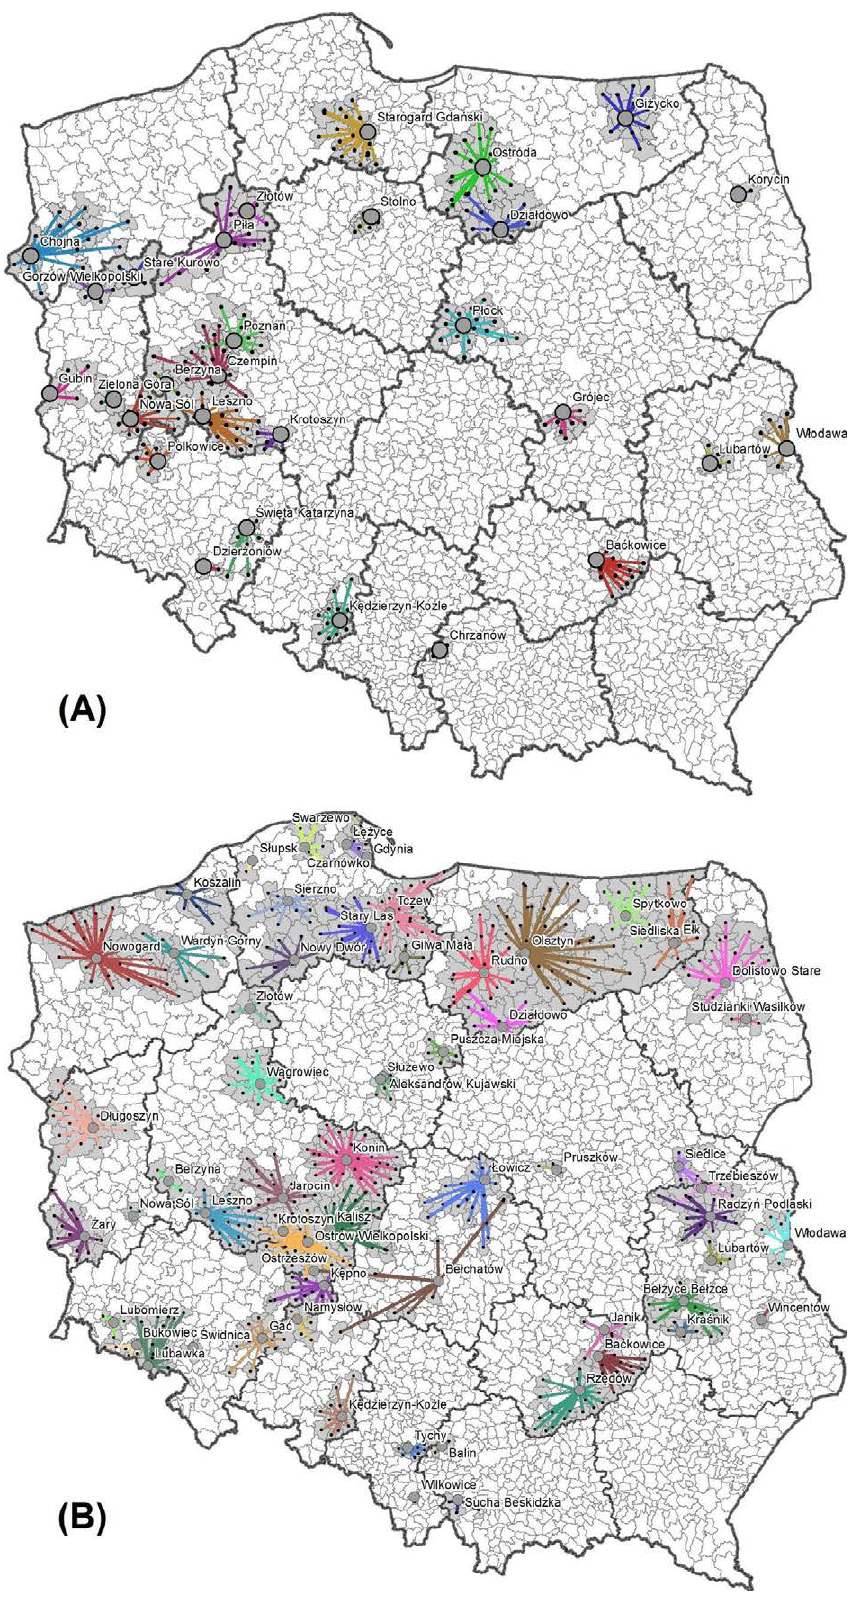
Fig. 1. Inter-municipal bodies involved in waste management in Poland: (A) waste collection, (B) waste processing. Source: own